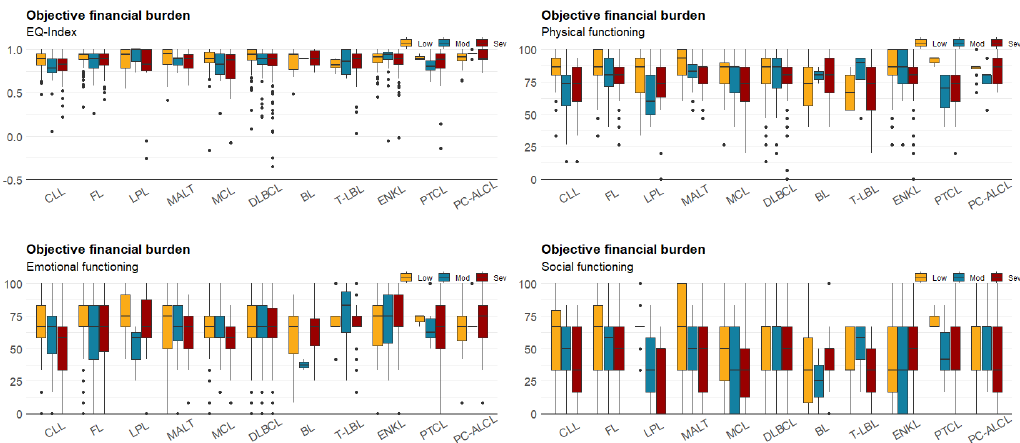
Figure 2. Boxplot for patients’ HRQoL and objective financial burden.